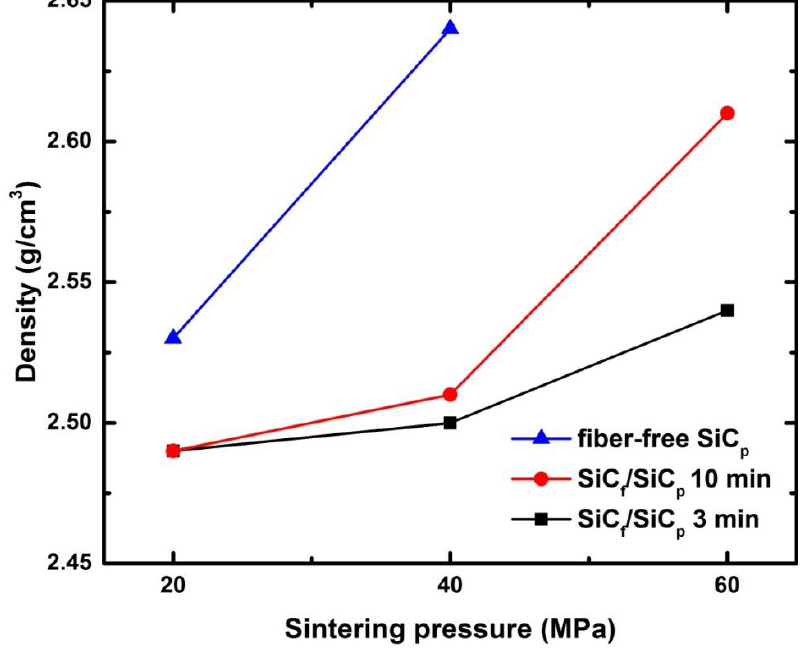
Figure 4. The density of the samples as the function of the sintering pressure.